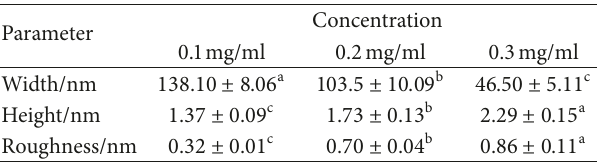
Table 1: Width, height, and roughness of the collagen self-assembly in different collagen